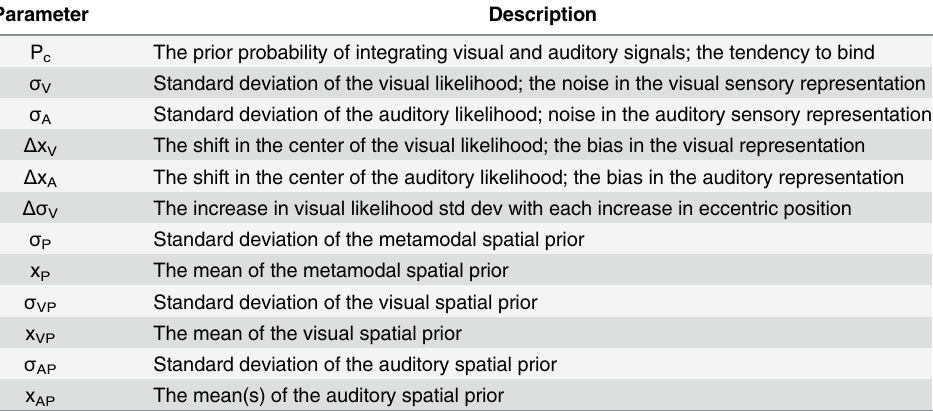
Table 1. Glossary table of all potential